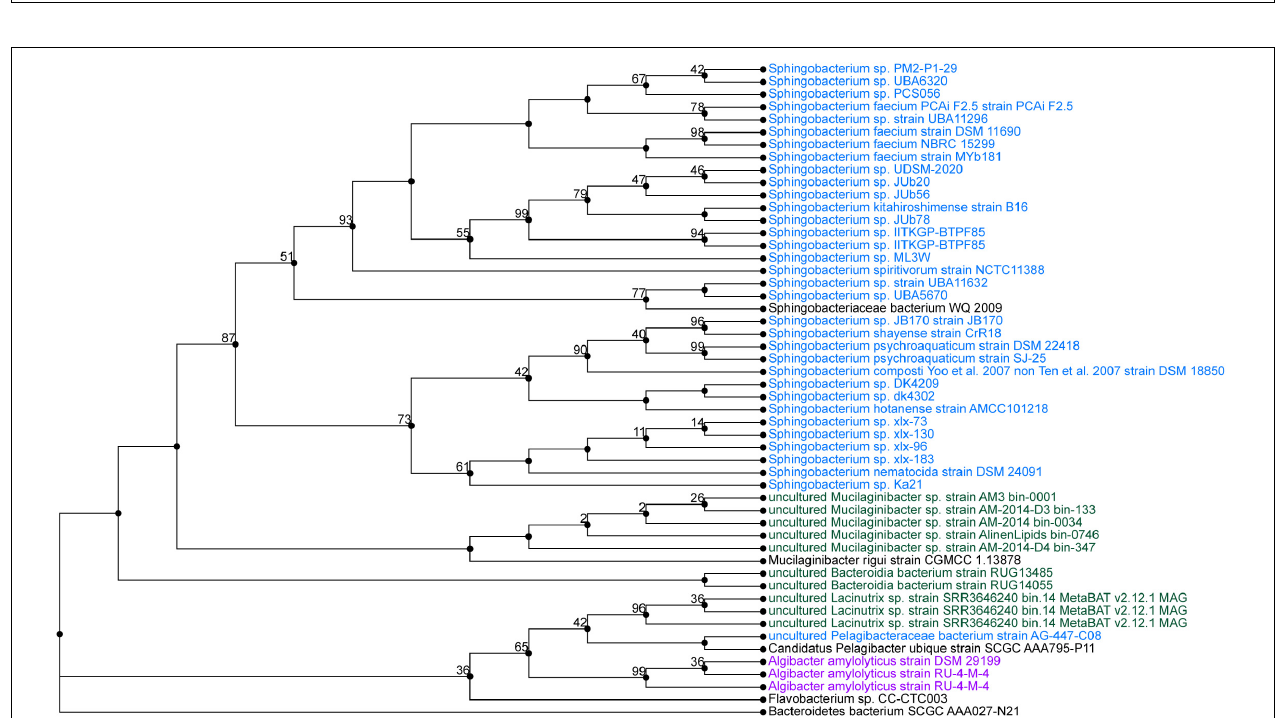
FIGURE 4 | Phylogenetic tree from maximum likelihood analysis of bacterial whole-genome sequence. The numbers in branch points denote confidence levels of the relationship of sequences determined by bootstrap statistical analysis. Pseudarthrobacter sp. SSS035 is grouped with A. sulfonivorans strain Ar51 with maximum confidence level of 92.